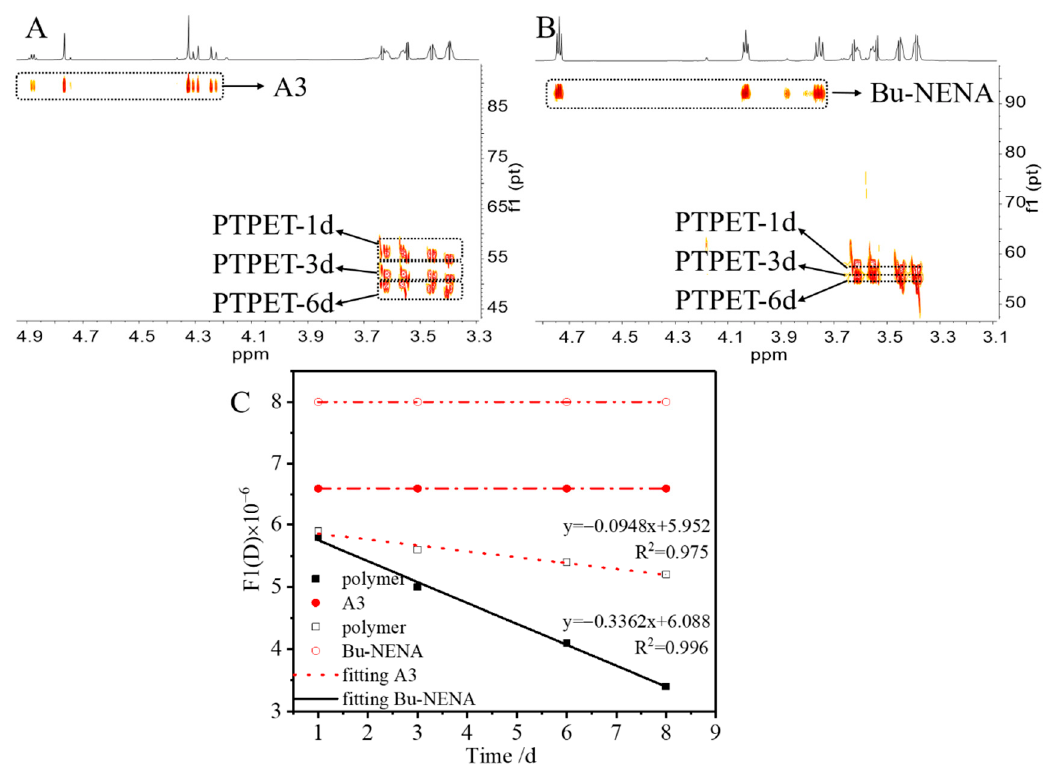
Figure 3. DOSY-NMR spectral analysis of PTPET/plasticizer mixtures at different times. ( A ) A3 system, ( B ) Bu-NENA system, ( C ) Relationships between diffusion coefficient and time for the above two reaction systems.